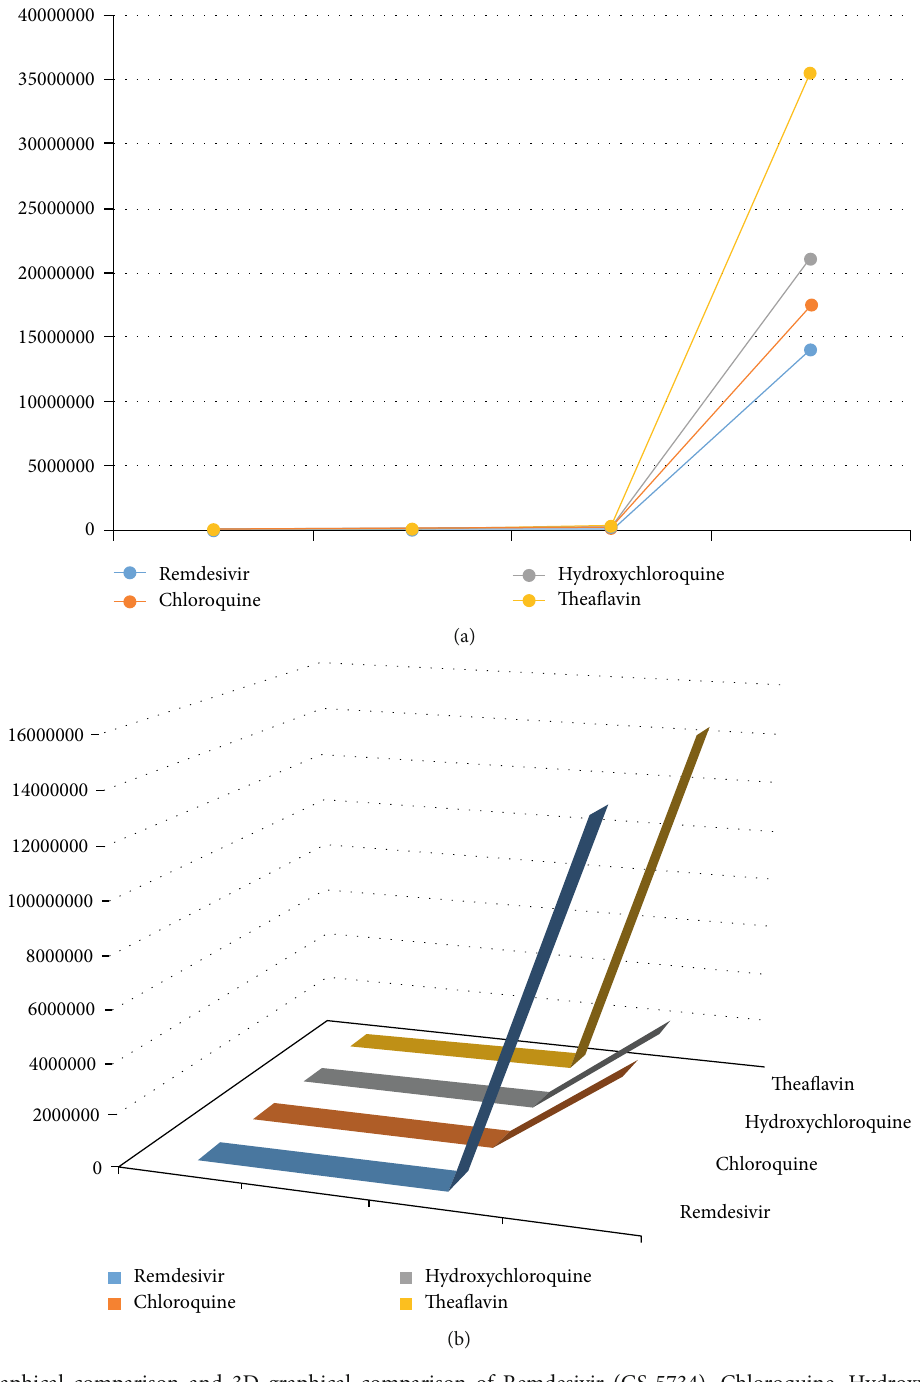
Figure 10: 2D graphical comparison and 3D graphical comparison of Remdesivir (GS-5734), Chloroquine, Hydroxychloroquine, and Thea fl